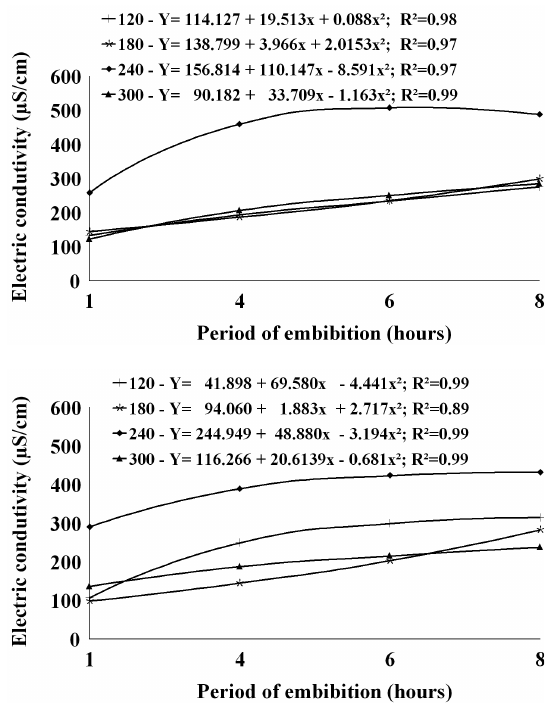
Fig. 5- Electric conductivity of Croton urucurana seeds under imbibition, stored at room temperature (a) and under refrigeration (b) at different